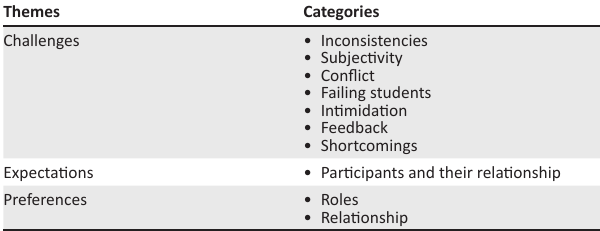
inhibiting open communication and trust as they lost their TABLE 1: Themes and categories that emerged from the